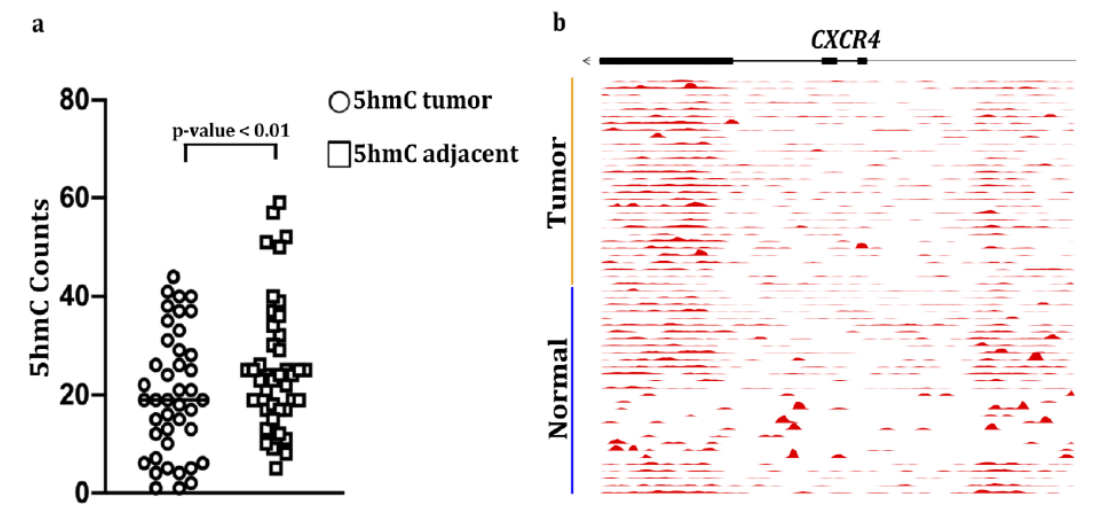
Figure 6. 5-hydroxymethylcytosine (5hmC) abundance in CXCR4 gene bodies in colon cancers and matched adjacent mucosa (n = 42 samples, p < 0.01, paired Student’s t -test): ( a ) Counts per million reads at CXCR4 gene, ( b ) plus promoter (upstream 3kb region) in matched tumors and adjacent healthy tissue in 30 colorectal cancer patients. The moving averages at 0.01 smoother span are shown. Black bars mark exons.